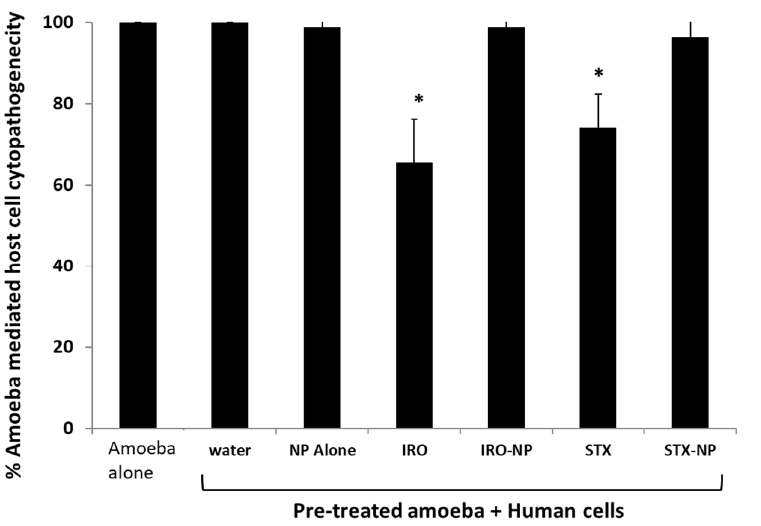
Figure 8. The effects of the Irosustat (IRO), STX140 (STX), and their respective nanoparticles on the cytopathogenicity mediated by A. castellanii were examined using cytopathogenicity assays. Notably, Irosustat and STX140 significantly decreased the cytopathogenicity of A. castellanii. The findings are shown as the mean ± sem (* represents p < 0.05).